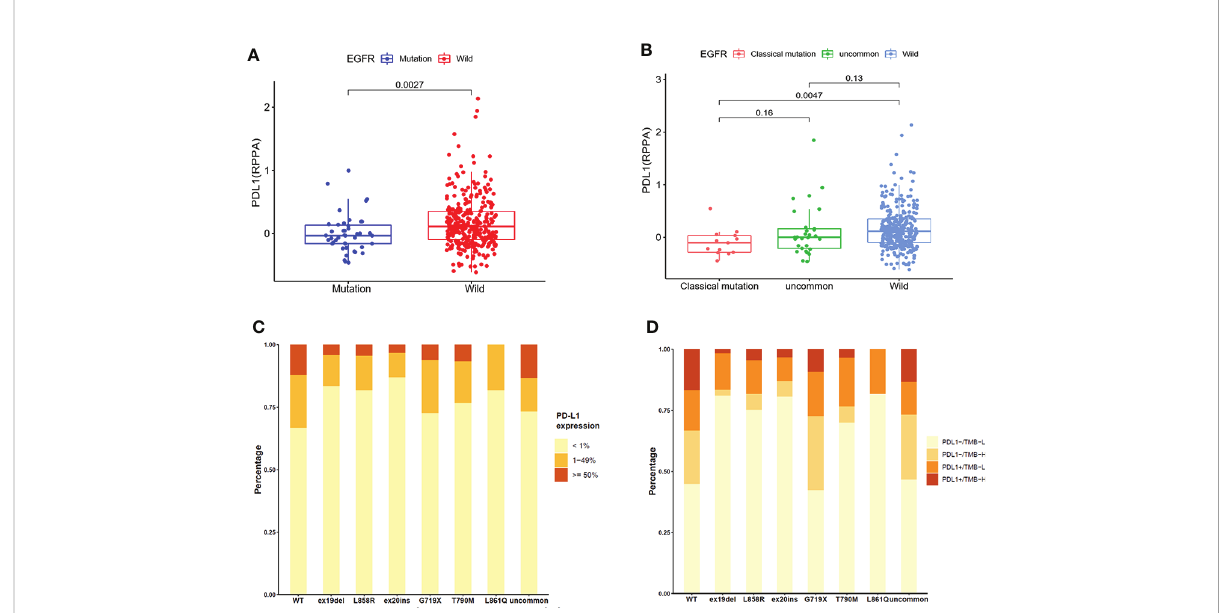
FIGURE 2 The expression of PD-L1 in TCGA database (A, B) and clinical center (C, D) . (A) Comparison of PD-L1 expression in NSCLC patients from TCGA database between EGFR wild-type and EGFR-mutated groups. (B) Comparison of PD-L1 expression in NSCLC patients from TCGA database between EGFR classical mutations, uncommon mutations, and EGFR wild-type groups. (C) The expression of PD-L1 in patients with different EGFR mutations in our clinical center. (D) The distribution of PD-L1-/TMB-L, PD-L1-/TMB-H, PD-L1+/TMB-L, and PD-L1+/TMB-H in NSCLC patients with different EGFR mutations in our clinical center.